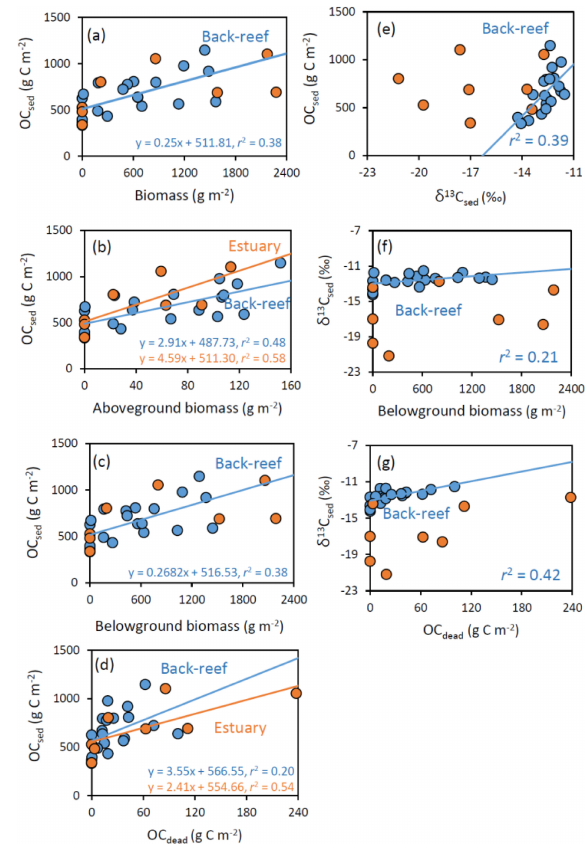
Figure 7. Relationships at the back-reef (blue) and estuarine (or- ange) sites between OC sed and (a) biomass (gm − 2 ) , (b) above- ground biomass (gm − 2 ) , (c) belowground biomass (gm − 2 ) , and (d) OC dead (gCm − 2 ) , and between (e) OC sed and δ 13 C sed , (f) δ 13 C sed and belowground biomass, and (g) δ 13 C sed and OC dead